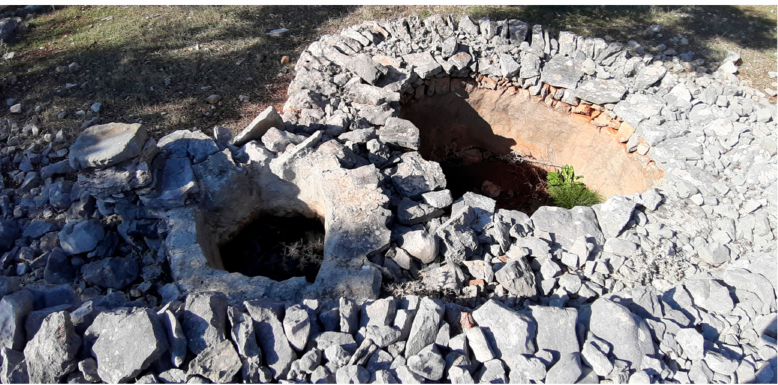
Figure 6. Vaške appear mainly in pairs: one as a water reservoir, the other as an pesticide reservoir. Several still retain blue colour traces from copper (II) sulphate (Karla Glavoˇci´c, 2019).